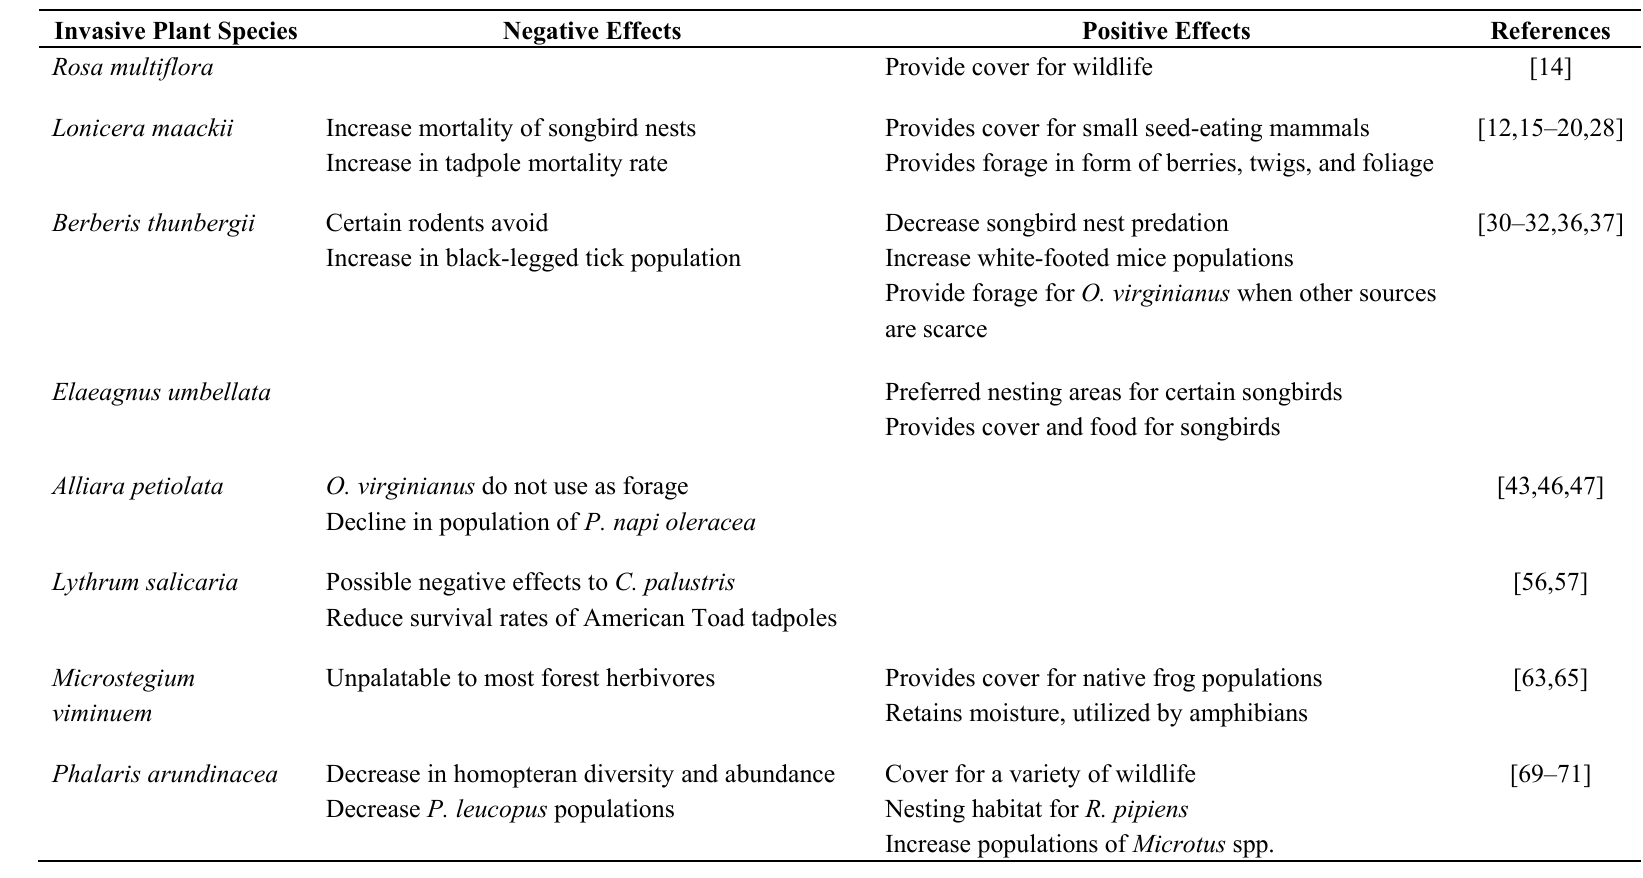
Table 1. Summary of negative and positive effects of invasive plant species on native fauna in eastern North